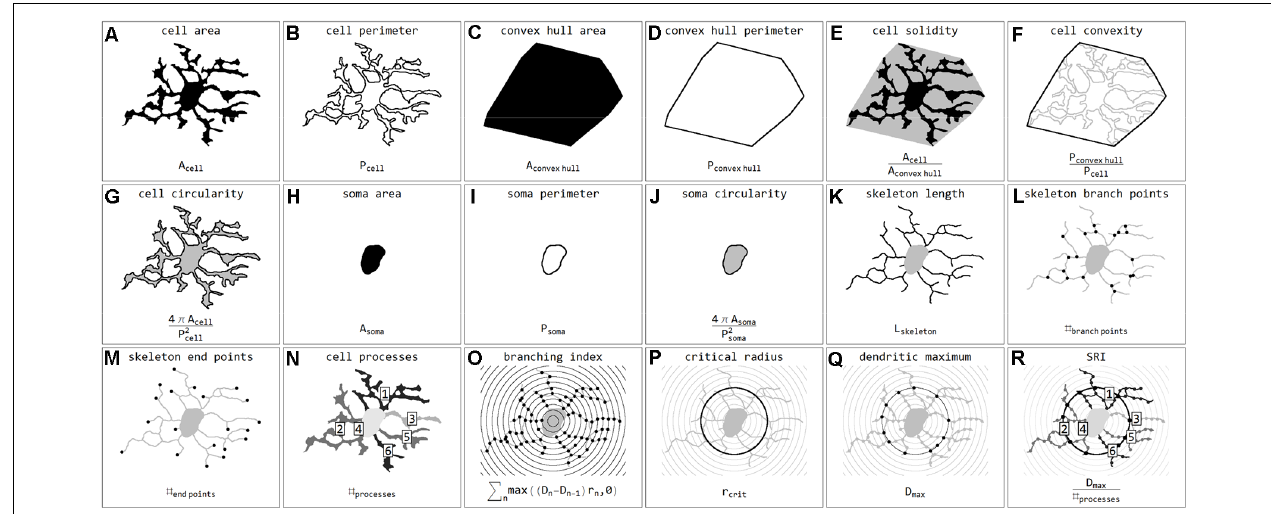
FIGURE 3 | Illustrations and formulas of all morphological parameters used for quantification of microglial cells (inspired by Fernández-Arjona et al., 2017). Parameters based on area (A,C,H) , perimeter (B,D,I) , combinations of area and perimeter (E,F,G,J) , skeleton (K,L,M) , processes (N) , and Sholl analysis (O,P,Q,R)